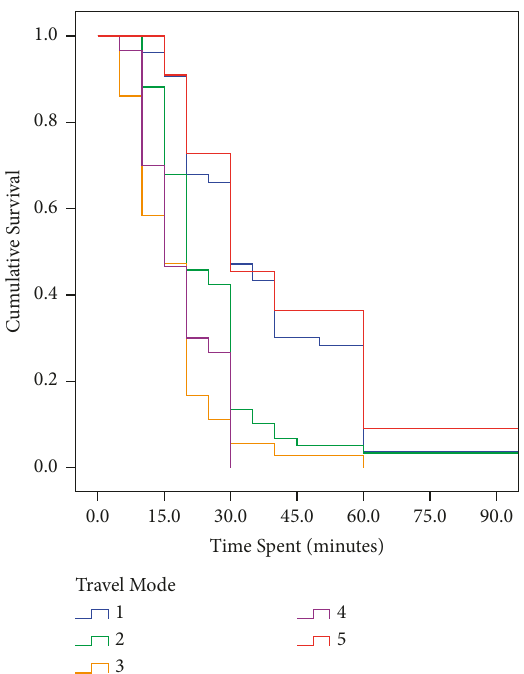
Figure 3: Survival function of the travel mode.